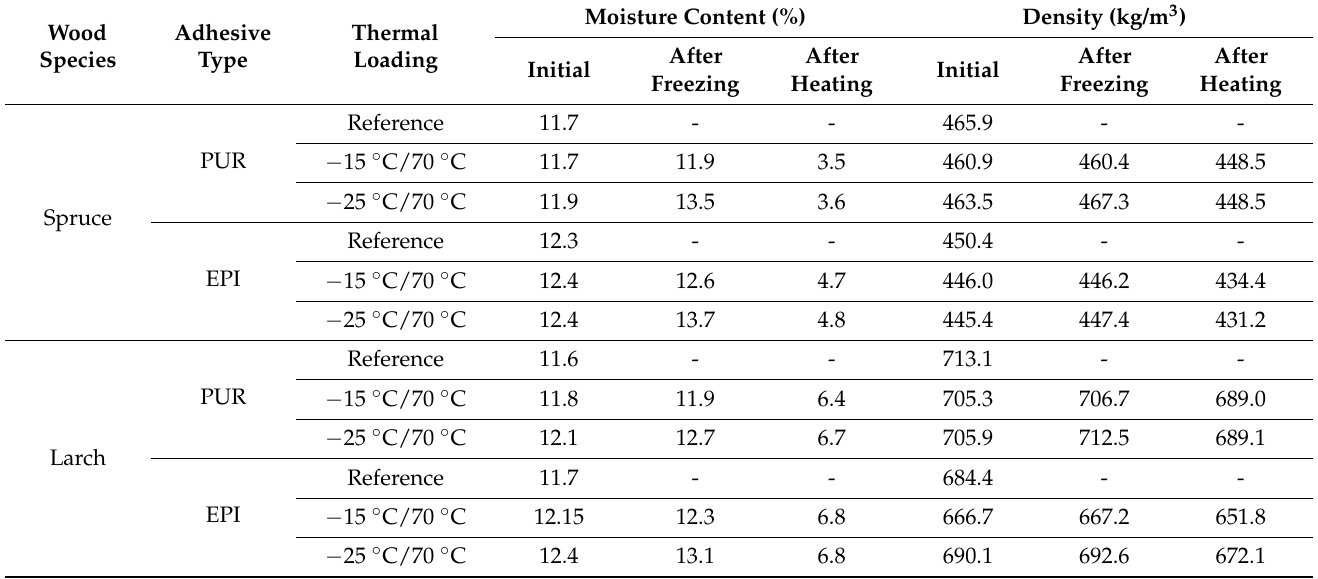
Table 2. Average density and moisture content of glued spruce and larch wood.